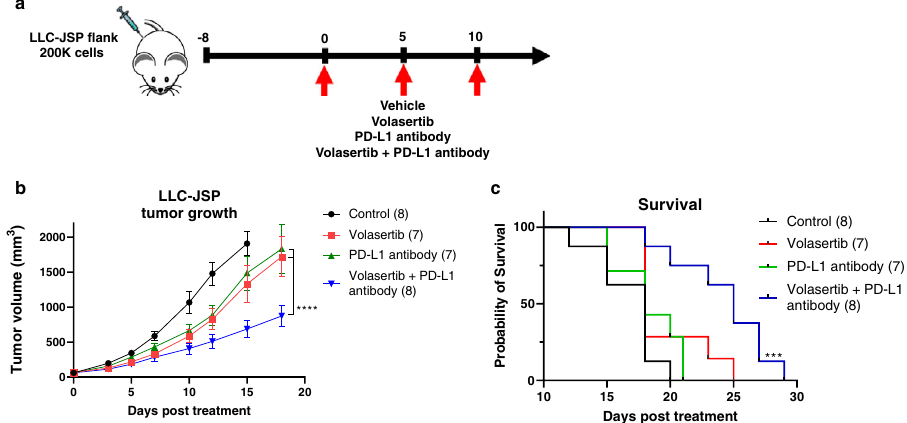
Fig. 3 PLK1 inhibition potentiates PD-L1 blockade in syngeneic lung tumors. a C57BL/6 mice were injected with 200,000 LLC-JSP cells on the right fl ank. On day 0 (8 post tumor inoculation), mice were grouped ( n = 7 – 8) and received i.p. treatments of control vehicles (PBS and HCl/saline), PLK1 inhibitor volasertib (20 mg/kg), PD-L1 antibody (10 mg/kg), or combination of PLK1 inhibitor and PD-L1 antibody at the same dose. Treatments were administered every 5 days for 3 doses. b Tumor growth of mice. Data presented as mean ± SEM; **** P < 0.0001 (mixed model Two-Way repeated measures ANOVA with Tukey ’ s correction for multiple comparisons). c Kaplan – Meier Survival curve. *** P = 0.0007 vs. saline (Log-rank Mantel – Cox test). Source data are provided as a Source Data fi